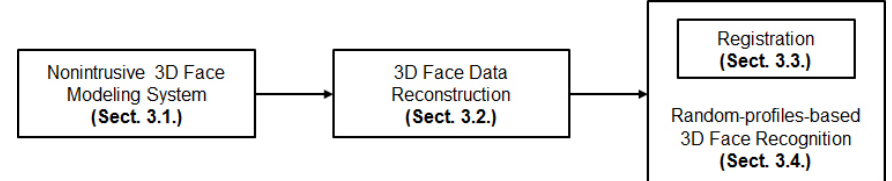
Figure 1. Overview of proposed